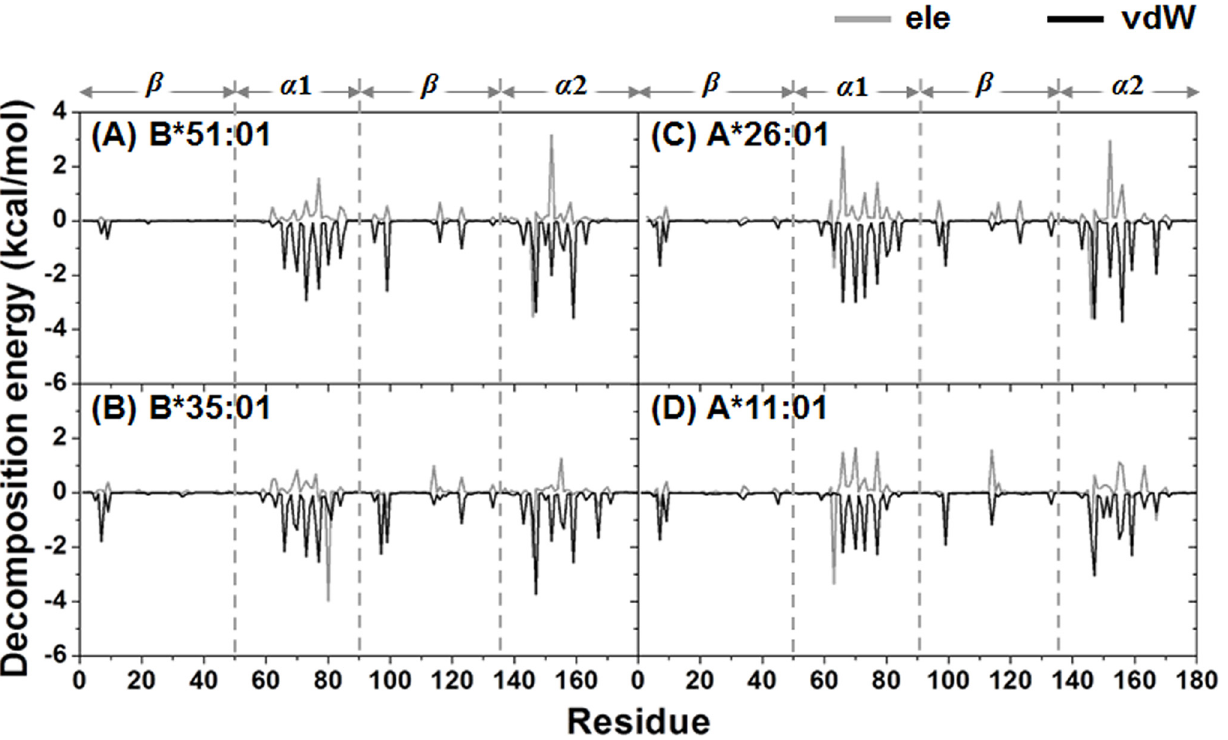
Fig 3. Decomposition energy per HLA residue fingerprint plots. The HLA contribution to the MICA-TM binding is shown in terms of the electrostatic (ele) and van der Waals (vdW) interactions.